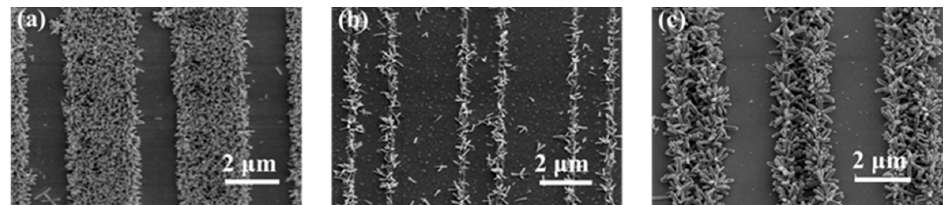
Figure 5. SEM images of TiO 2 lines without residual layer obtained by hydrothermal reaction for ( a ) 4 h on the inducer 1, for ( b ) 4 h on the inducer 2 and for ( c ) 8 h on the inducer